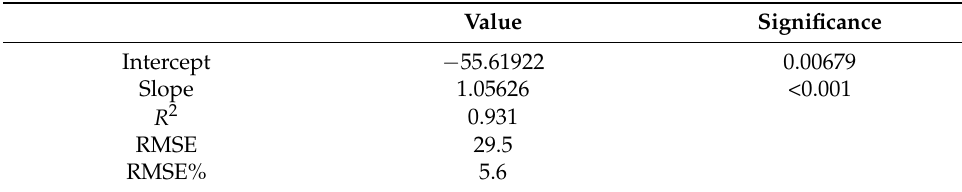
Table 5. Parameters of the regression analysis of total OHTyr + Tyr determined by NADES-UV versus total OHTyr + Tyr determined by acid hydrolysis and